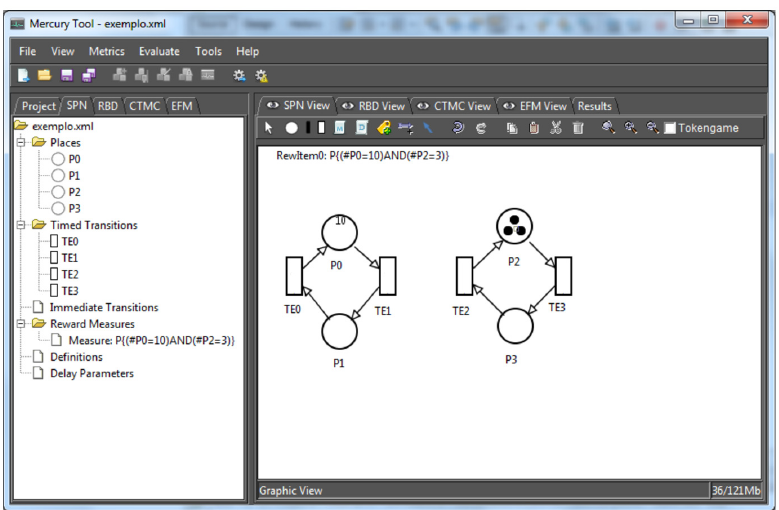
Figure 9. Mercury: SPN editor and evaluator.